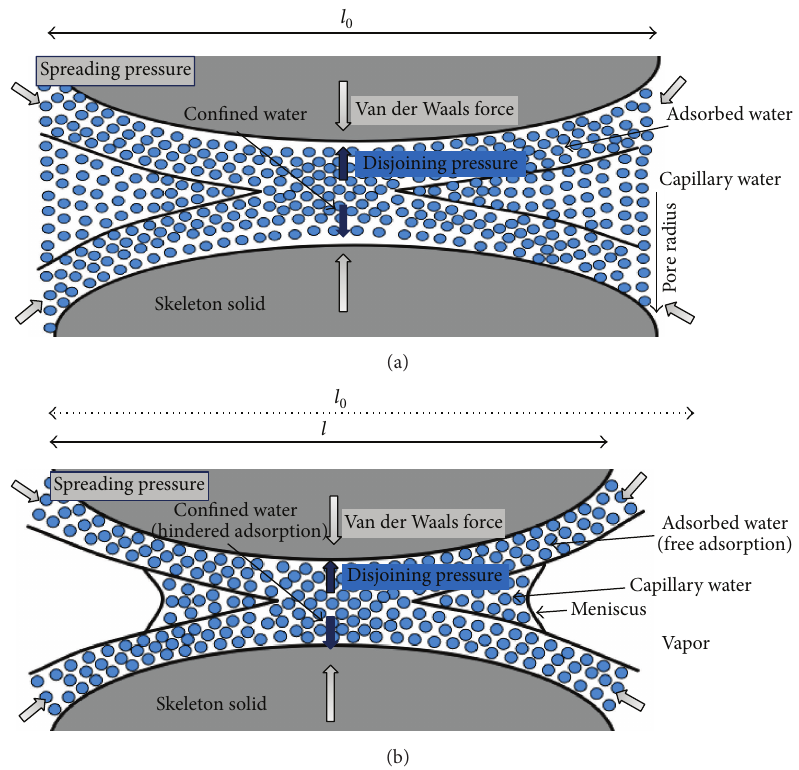
Figure 6: Schematic illustration of drying process in hindered adsorption region and withdrawal of disjoining pressure: (a) initial status, (b) after RH decreases. This figure shows the simultaneous occurrence of surface free energy-induced shrinkage and withdrawal of disjoining pressure-induced